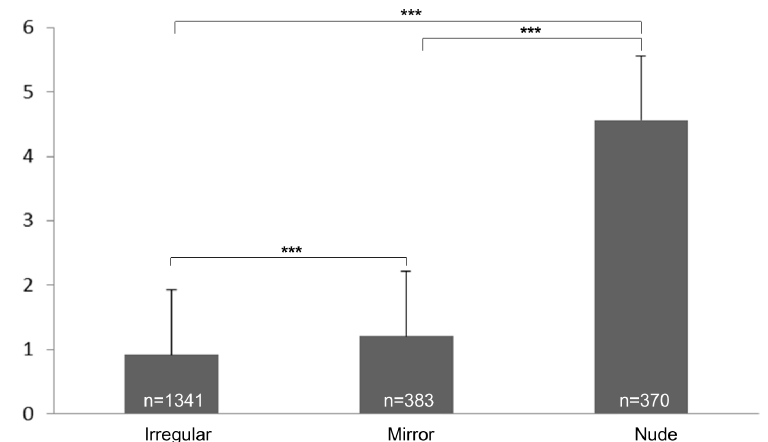
Figure 3. Association between the level of scale loss and fin defects in irregular, mirror and nude phenotypes across nine families. (A) Fin defects were quantified on a per fish basis using an arbirary scale (absence: 1 point, stunting: 0.75 point, reduction: 0.5 point and slight reduction: 0.25 point). The average of fin defects per fish are plotted for each group along with the standard deviation. *** indicates P-value ( , 0.005) calculated using Student’s t-test. Numbers in white at the bottom of the bars indicate the number of individuals analyzed from each scale-pattern type.